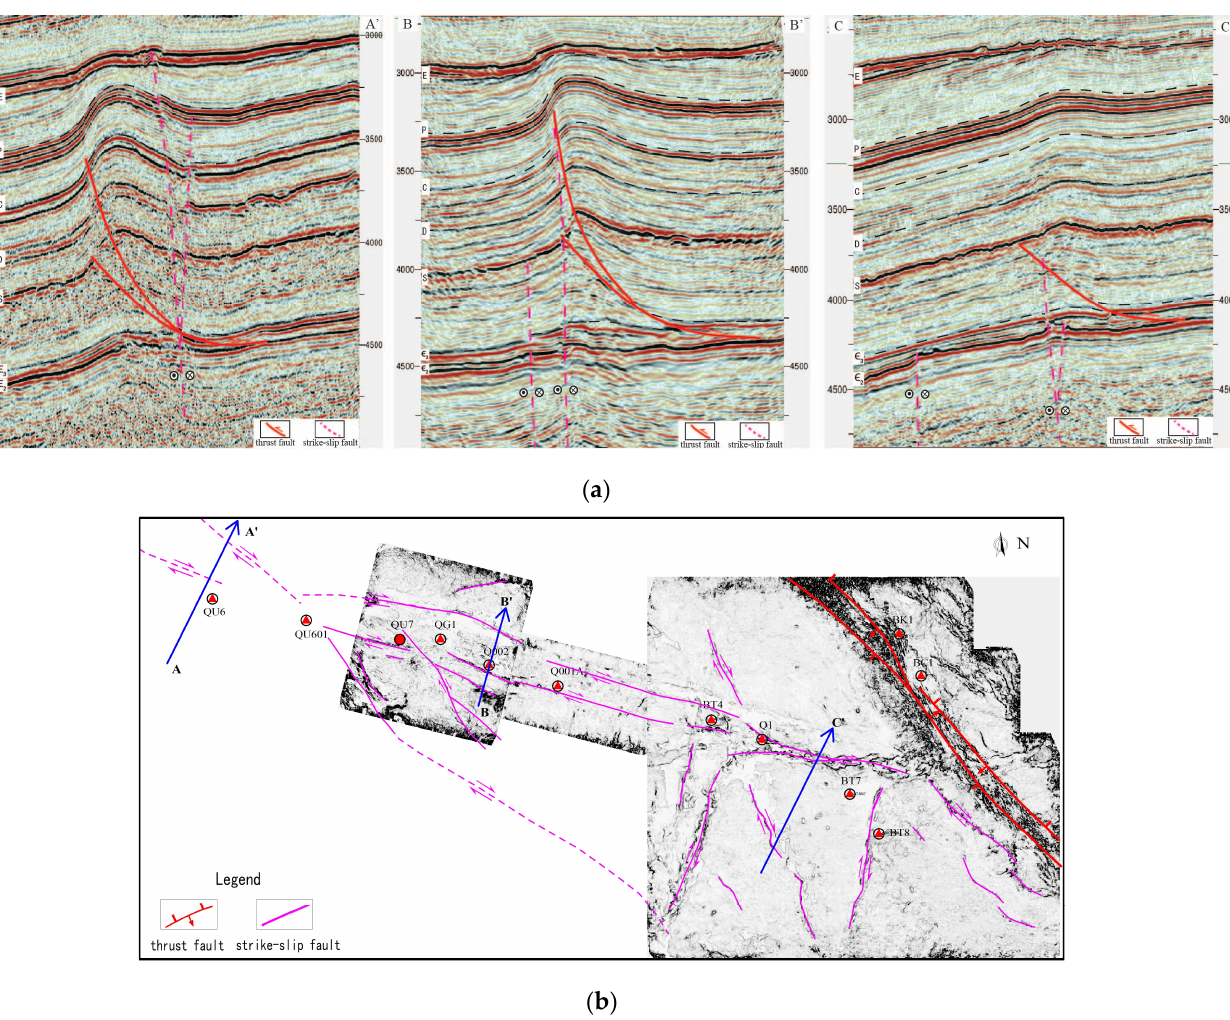
Figure 4. Characteristics of strike-slip fault in western part of Maigaiti Slope. ( a ) Characteristics of strike-slip fault profiles in western part of Maigaiti Slope. ( b ) Middle Cambrian bottom coherence of strike-slip fault about 3D seismic data in western part of Maigaiti Slope.